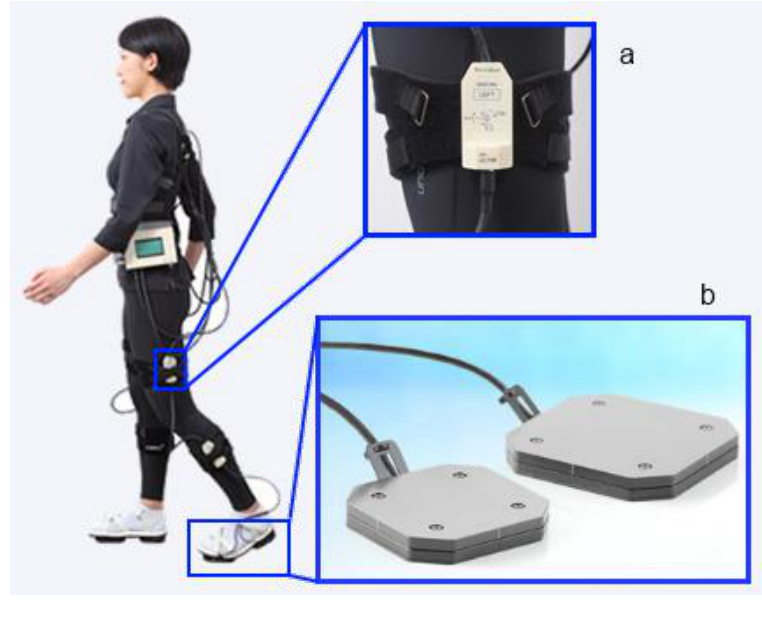
Figure 13. WS system based on ( a ) inertial sensors and ( b ) wearable force plates. Reproduced with permission from Tec Gihan